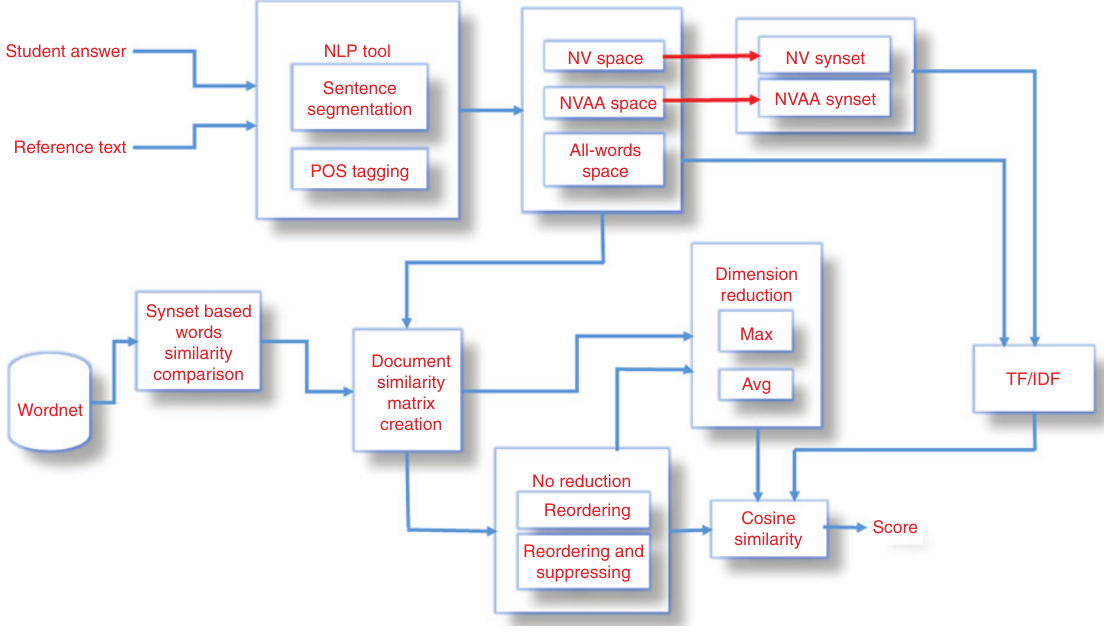
Figure 1: Sentence Similarity-Based Student Answer Script Evaluation